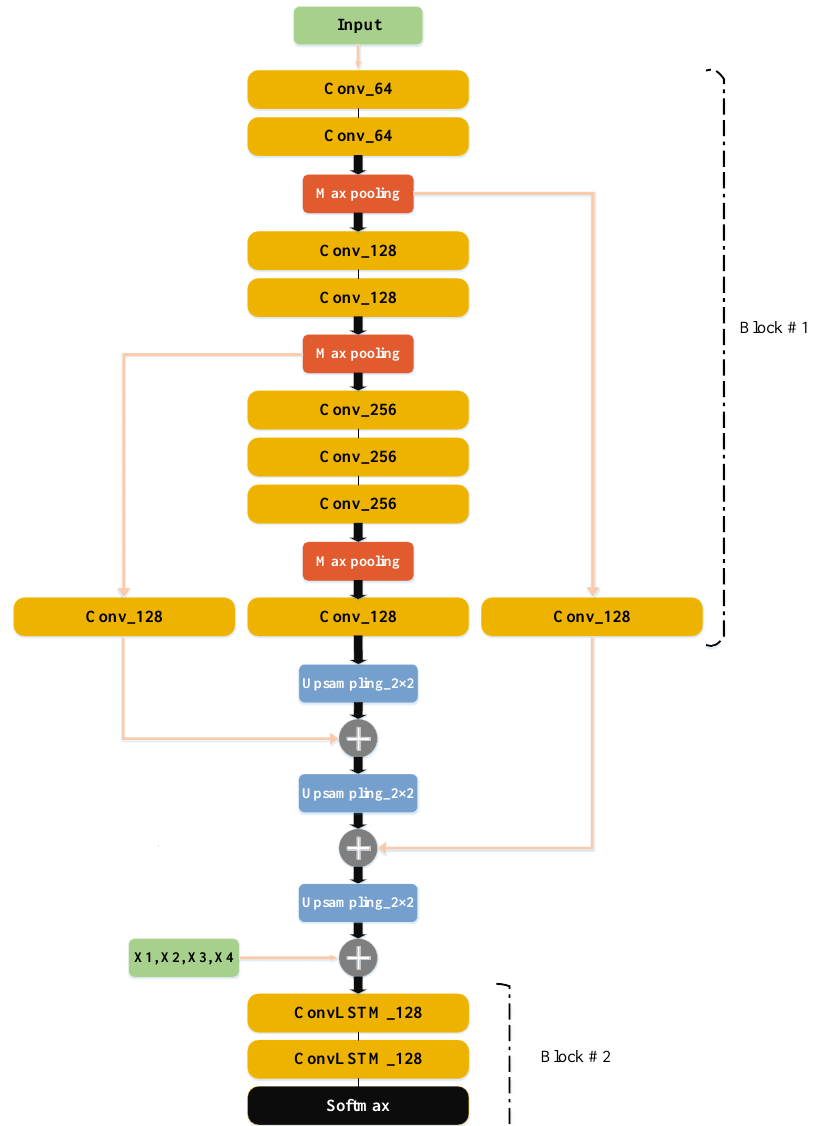
Figure 4. Illustration of our approach based on the combined fully convolutional network (FCN) and ConvLSTM